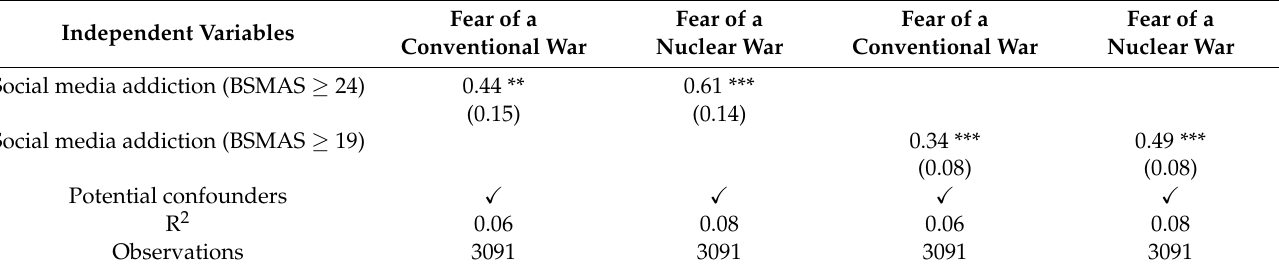
Table 2. Social media addiction and fear of war. Results of multiple linear